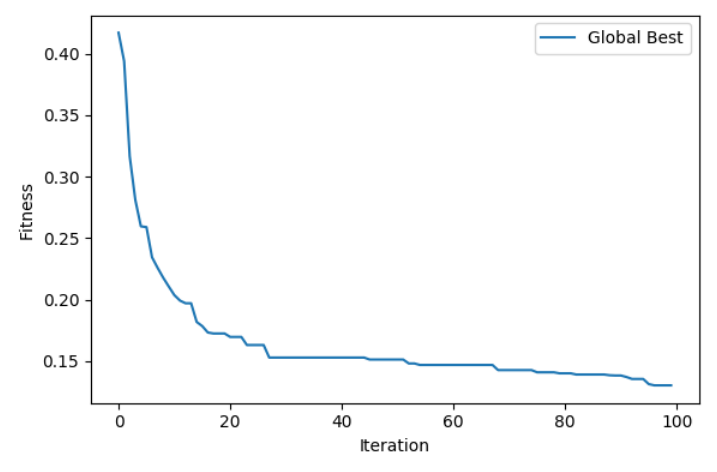
Figure 5. Fitness value of the global best particle throughout the optimisation process using the BLSK-NS weight inheritance